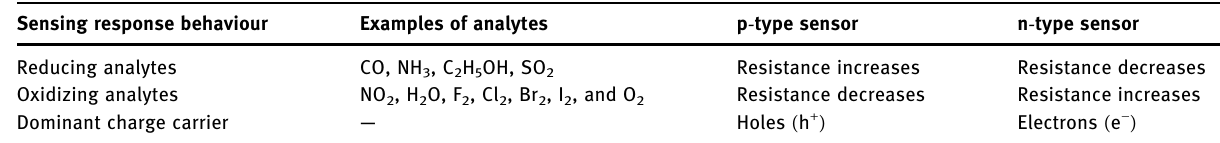
Table 3: Sensing response behaviour of p - type and n - type sensors to reducing and oxidizing analytes Sensing response behaviour